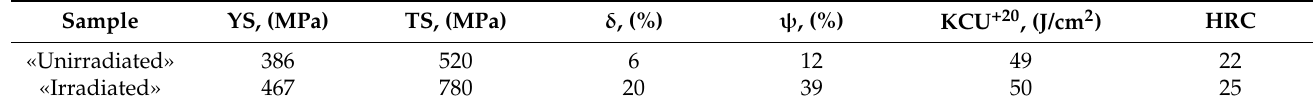
Table 3. Results of mechanical testing of steel 35L